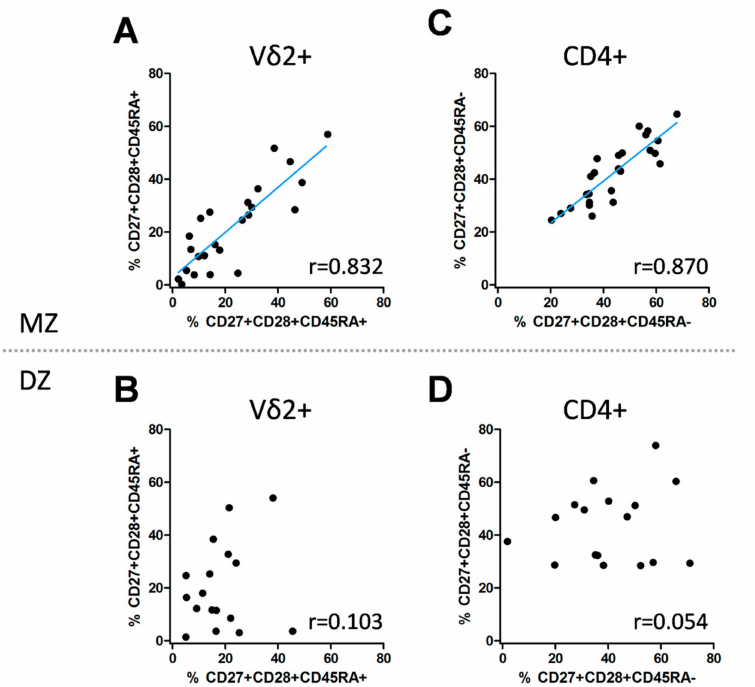
Figure 4. Correlation of the T cell differentiation status in monozygotic and dizygotic co-twins. CD27+CD28+CD45RA+ V δ 2+ T cells ( A , B ) and CD27+CD28+CD45RA– CD4+ T cells ( C , D ) correlated strongly in MZ but not in DZ co-twins. The Spearman correlation coefficient r as well as the intraclass correlation coefficient (ICC) and corresponding p -values and confidence intervals (CI) were calculated (Table